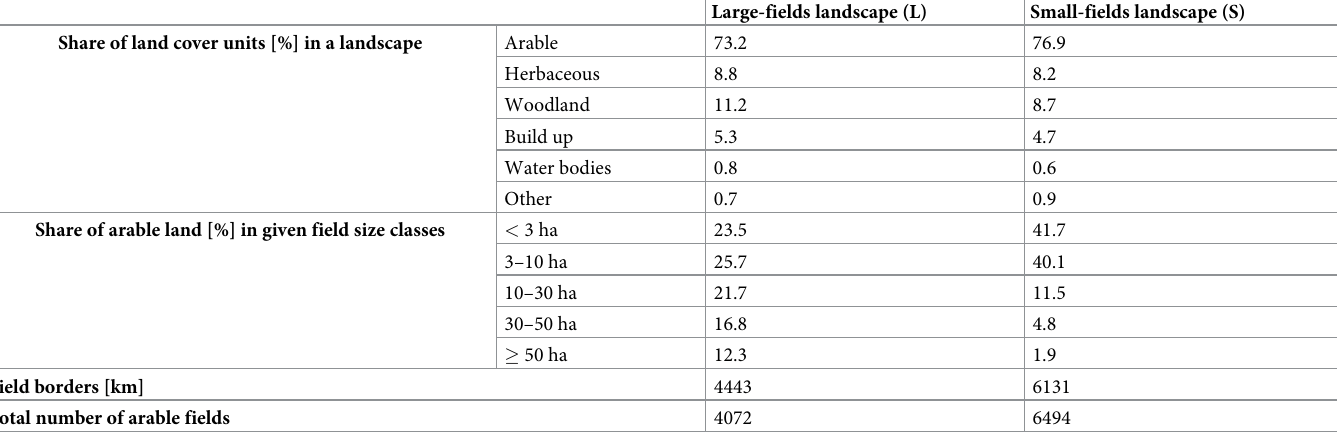
Table 1. Two study landscapes, each 12 x 16 km, with share of land of the main land cover types [%], share of arable land in given field size classes [%], field border length [km] and total number of arable fields.